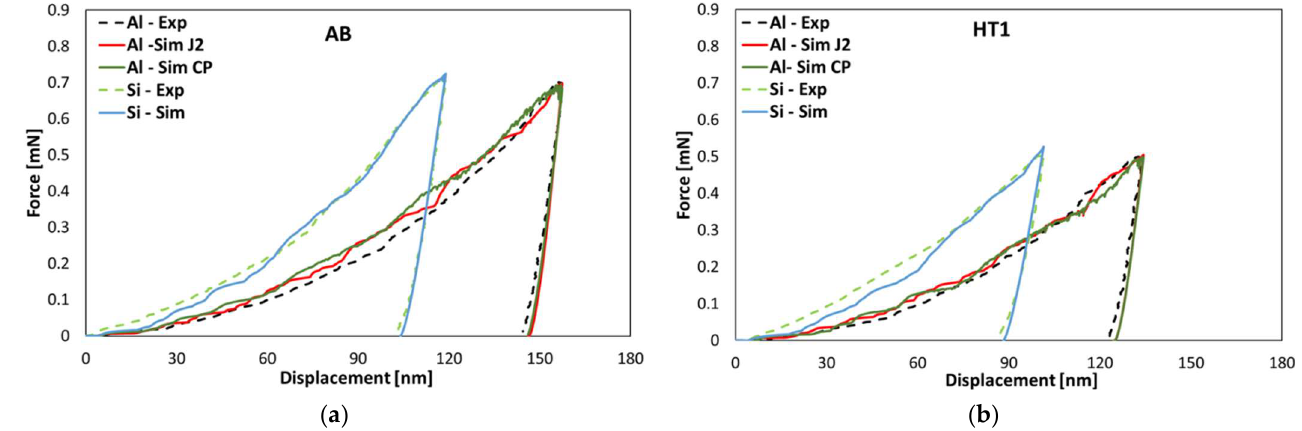
Figure 8. Comparison of the force-displacement curves obtained from the nanoindentation experi- ment as well as the J2 and CP models for Al and Si-rich phases: ( a ) AB and ( b ) HT1 states. The Nelder–Mead algorithm [64,65], available in the open source python library Here, n is the number of data points; p 0 and p e are the initial and final depths, respec- SciPy [66], was employed for inverse analysis. The optimum material parameters were tively; and f exp p and f sim are the forces obtained from the experiment and simulation at p determined by the minimization of the objective function. The optimized parameters ob- depth p . tained for the J2 and CP models are listed in Tables 2 and 3, respectively. Table 2. Optimized J2 parameters for the Al and Si-rich phases derived by inverse analysis. See text for details.